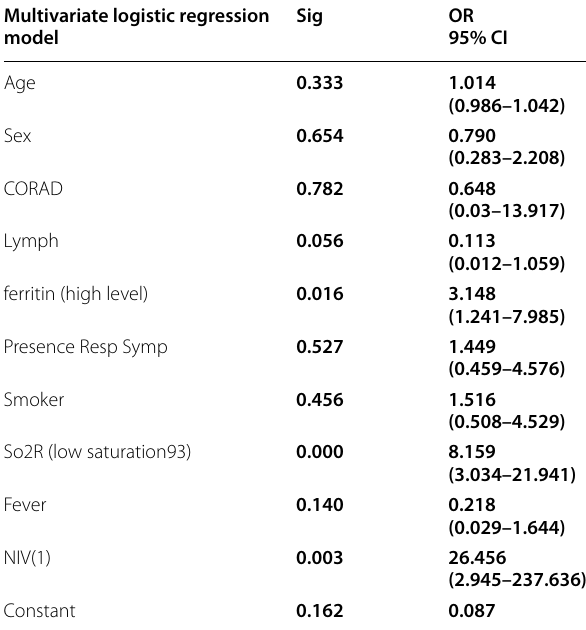
Table 2 Multivariate logistic regression model for prediction of admission to